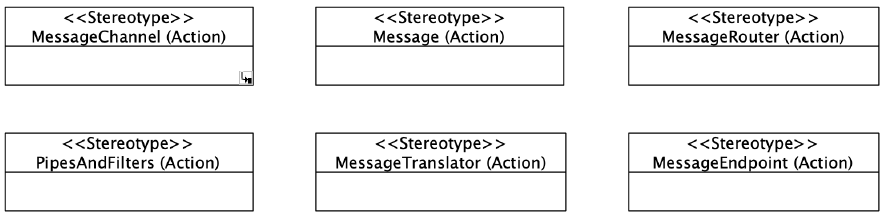
Figure 3. UML profile diagram with declared stereotypes for messaging systems.